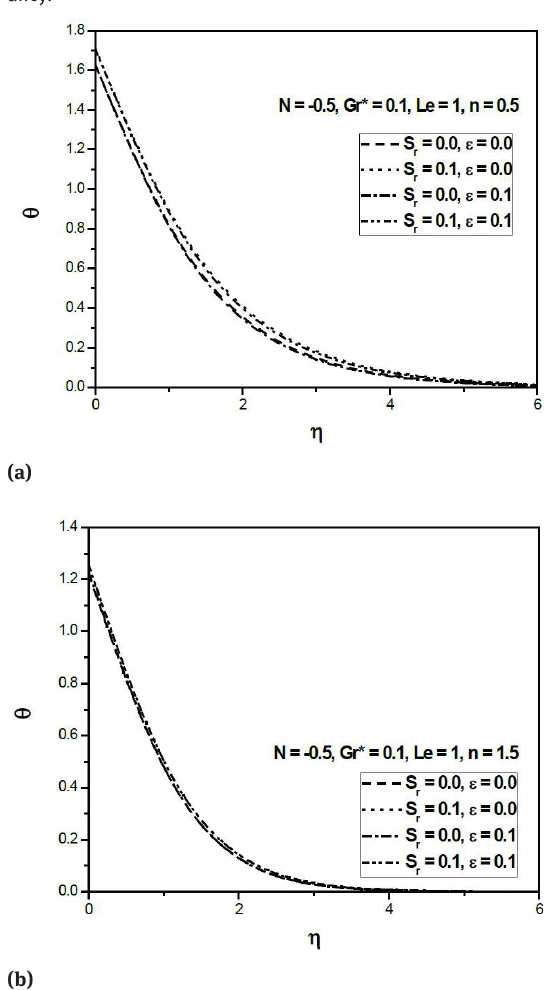
Fig. 6: (a) Variation of temperature profiles against η for n = 0.5 (Opposing Buoyancy); (b) Variation of temperature profiles against η for n = 1.5 (Opposing